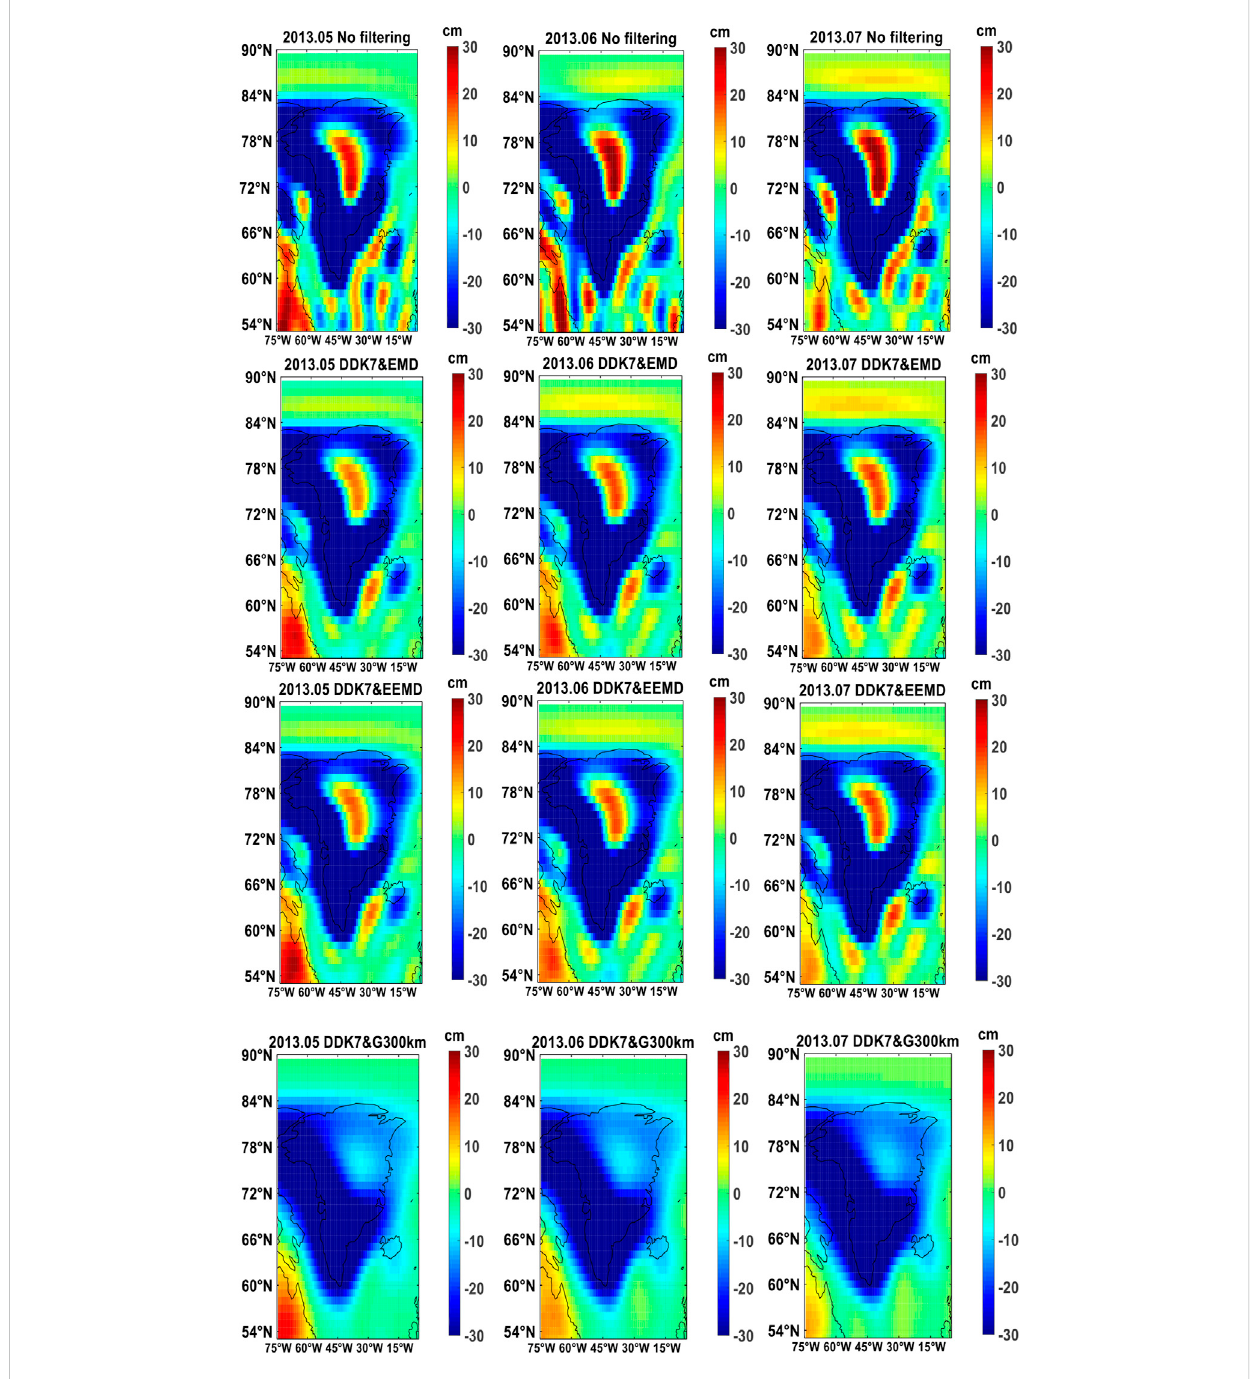
FIGURE 8 EWH map in Greenland after EEMD, EMD, Gaussian smoothing 300 km (G300 km) together with DDK7 and No fi ltering.